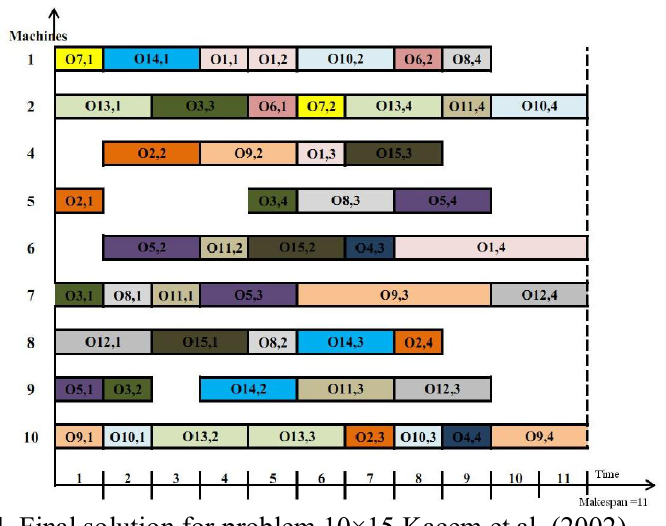
Fig. 4. Final solution for problem 10×15 Kacem et al. (2002)